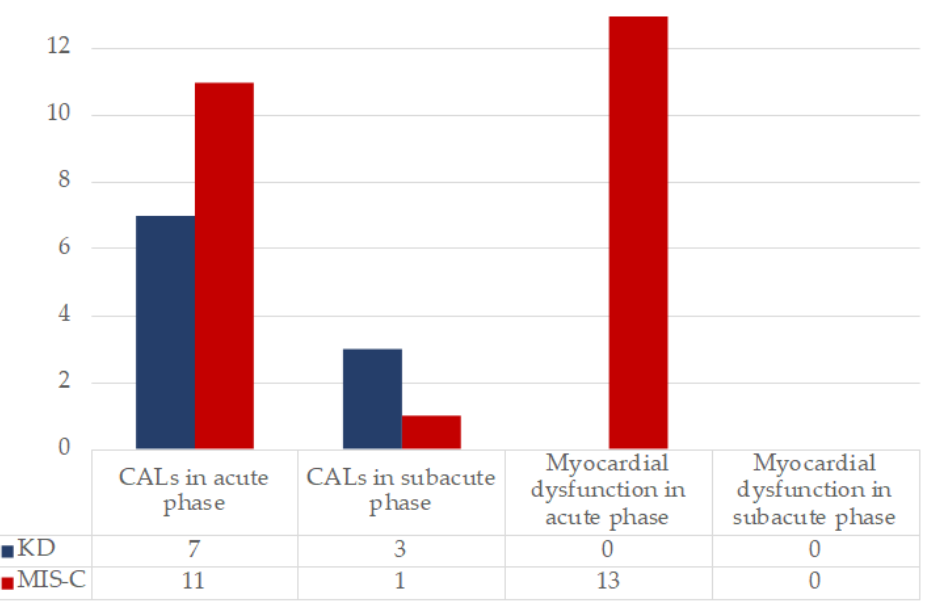
Figure 1. Evolution of cardiac involvement during acute and subacute phase in KD and MIS-C. On the y axis, the number of patients presenting the specific feature is reported.